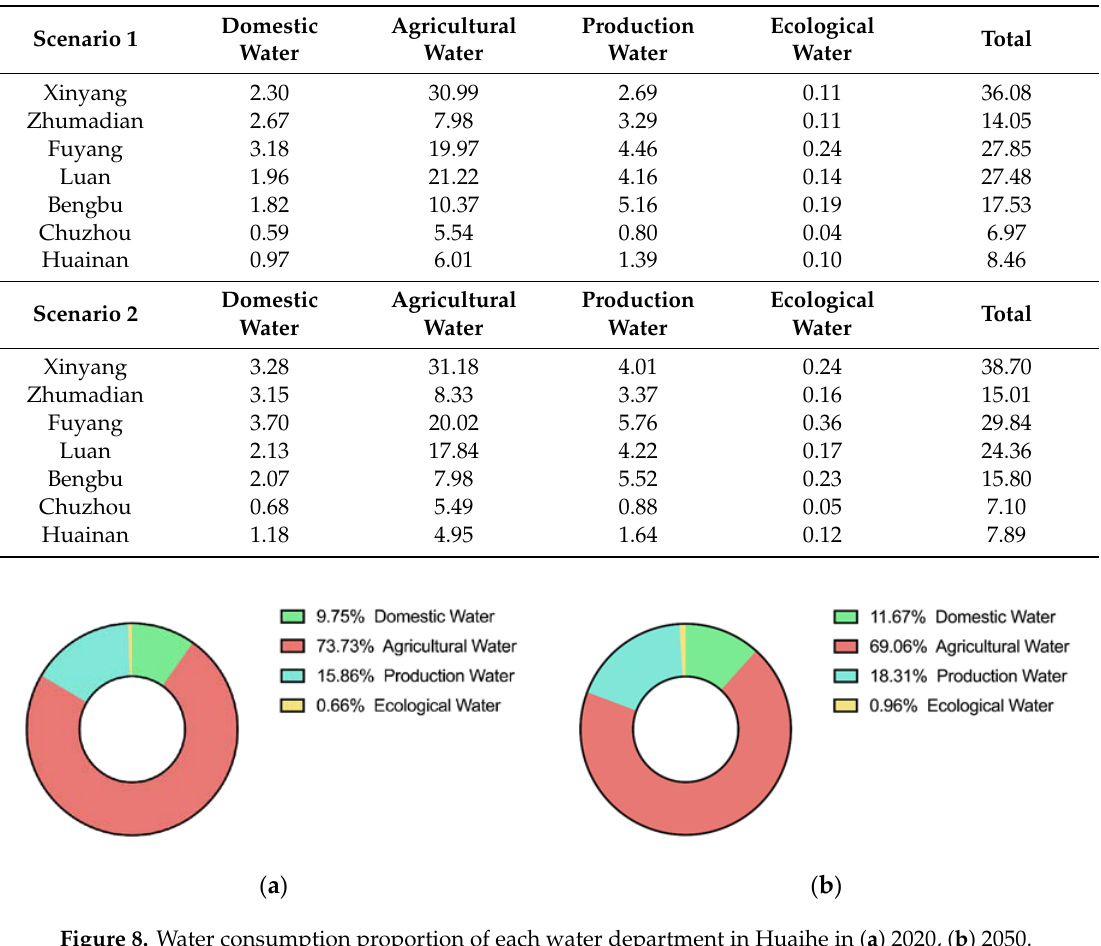
Figure 8. Water consumption proportion of each water department in Huaihe in ( a ) 2020, ( b ) 2050. Int. J. Environ. Res. Public Health 2020 , 17 , x Table 3. Water supply of each water source in Huaihe River Basin in 2020 and 2050 (10 8 m 3 ).